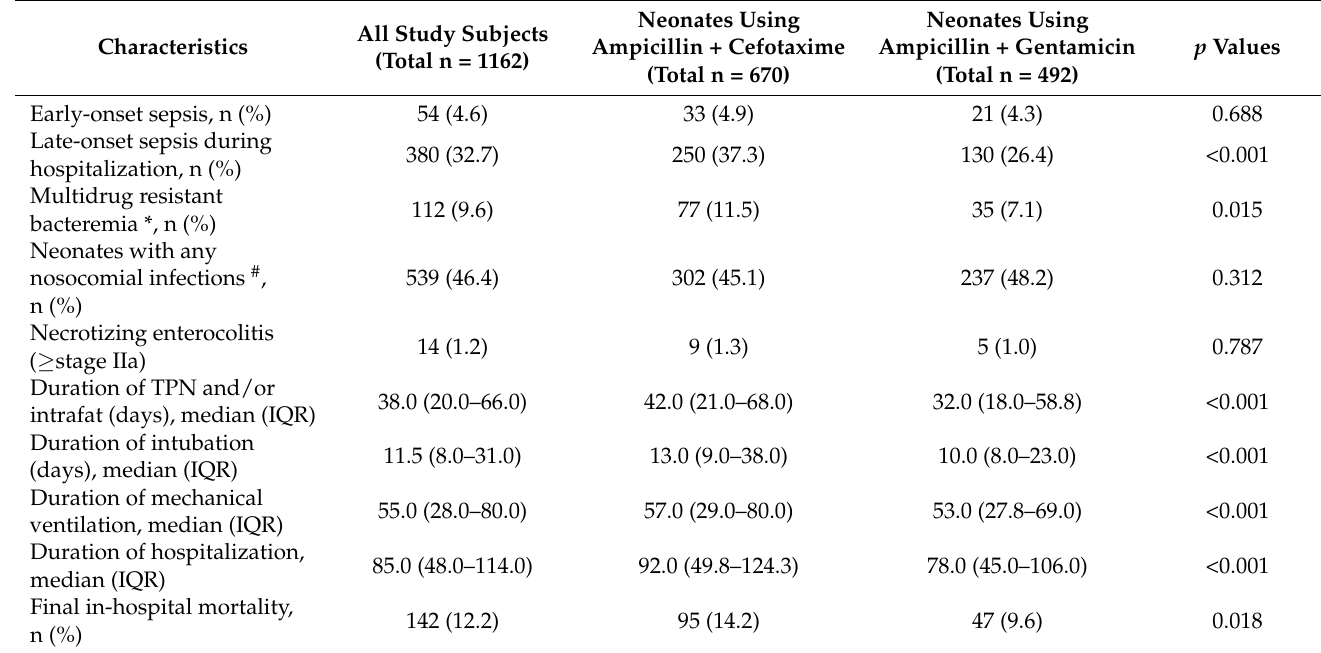
Table 2. Hospital courses and outcomes of neonates using ampicillin plus cefotaxime compared with those using ampicillin plus gentamicin as empiric